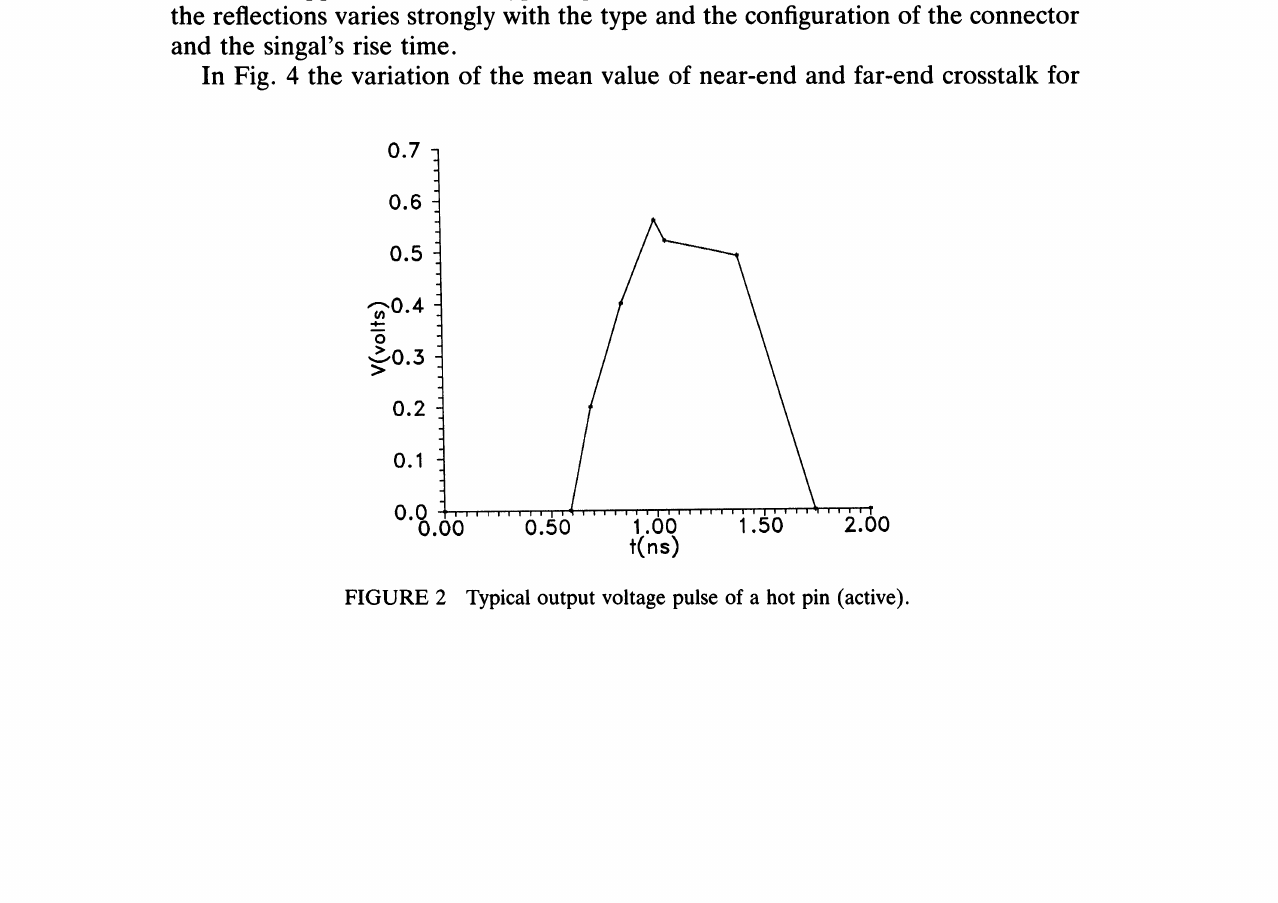
FIGURE 2 Typical output voltage pulse of a hot pin